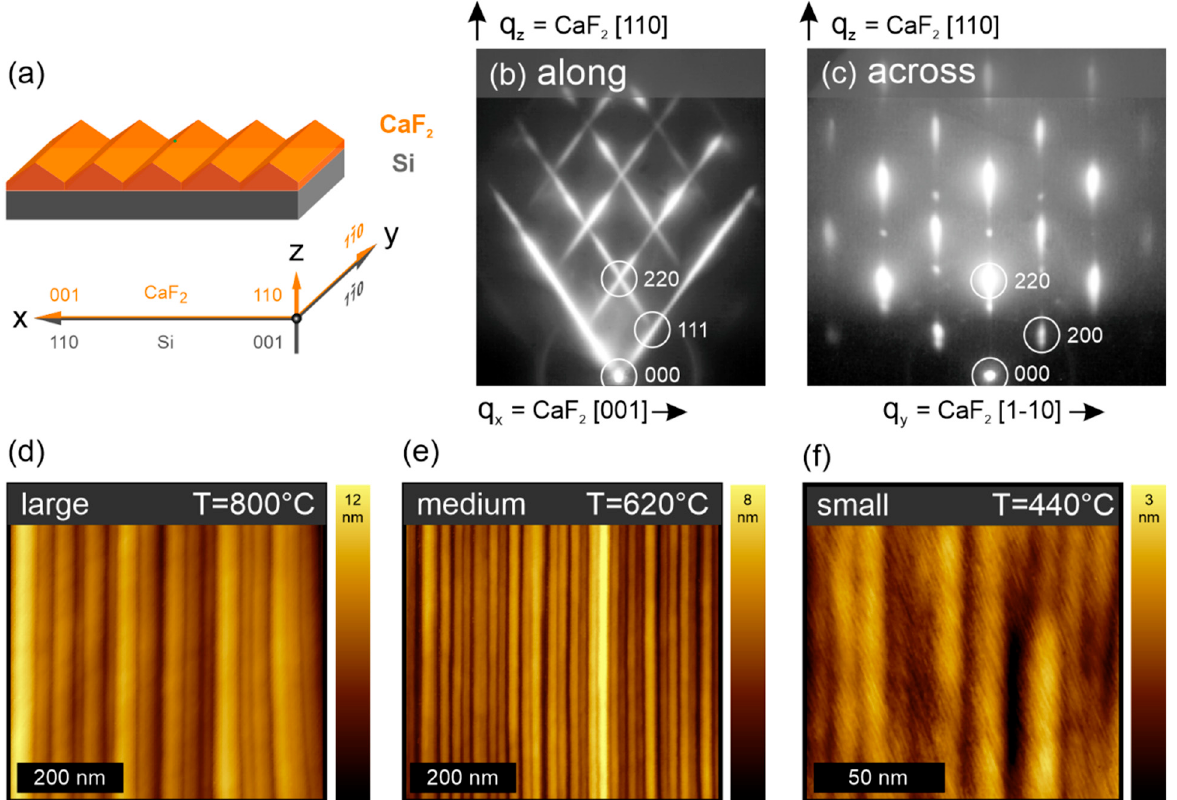
Figure 1. A schematic drawing of the fluorite ridge shaped stripes and the corresponding epitaxial relations between CaF 2 and Si ( a ). Reflection high energy electron diffraction (RHEED) reciprocal space maps obtained with the e-beam incident along ( b ) and across ( c ) the stripes. The inclined streaks correspond to the grazing incidence diffraction from the {111} side slopes of the ridge. A series of AFM images of CaF 2 stripes grown at 800 °C ( d ), 620 °C ( e ) and 440 °C ( f ). The corresponding inter-stripe periods are 33, 18 and 10 nm. Axis q z is perpendicular to the substrate surface, axis q x is perpendicular to the stripes.